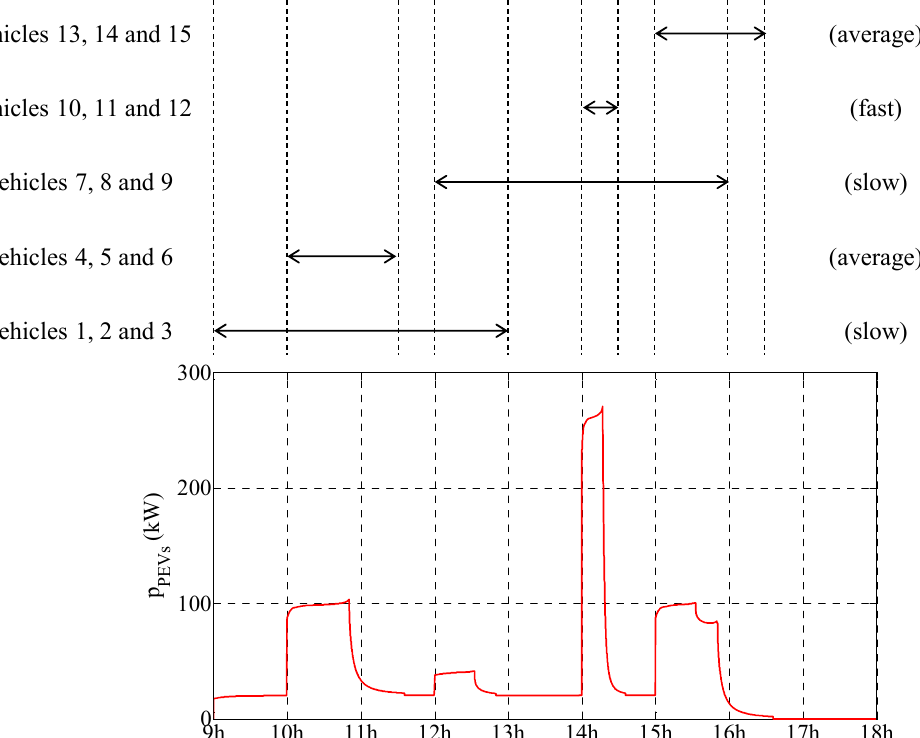
Figure 6. Plug-in electric vehicles’ total power